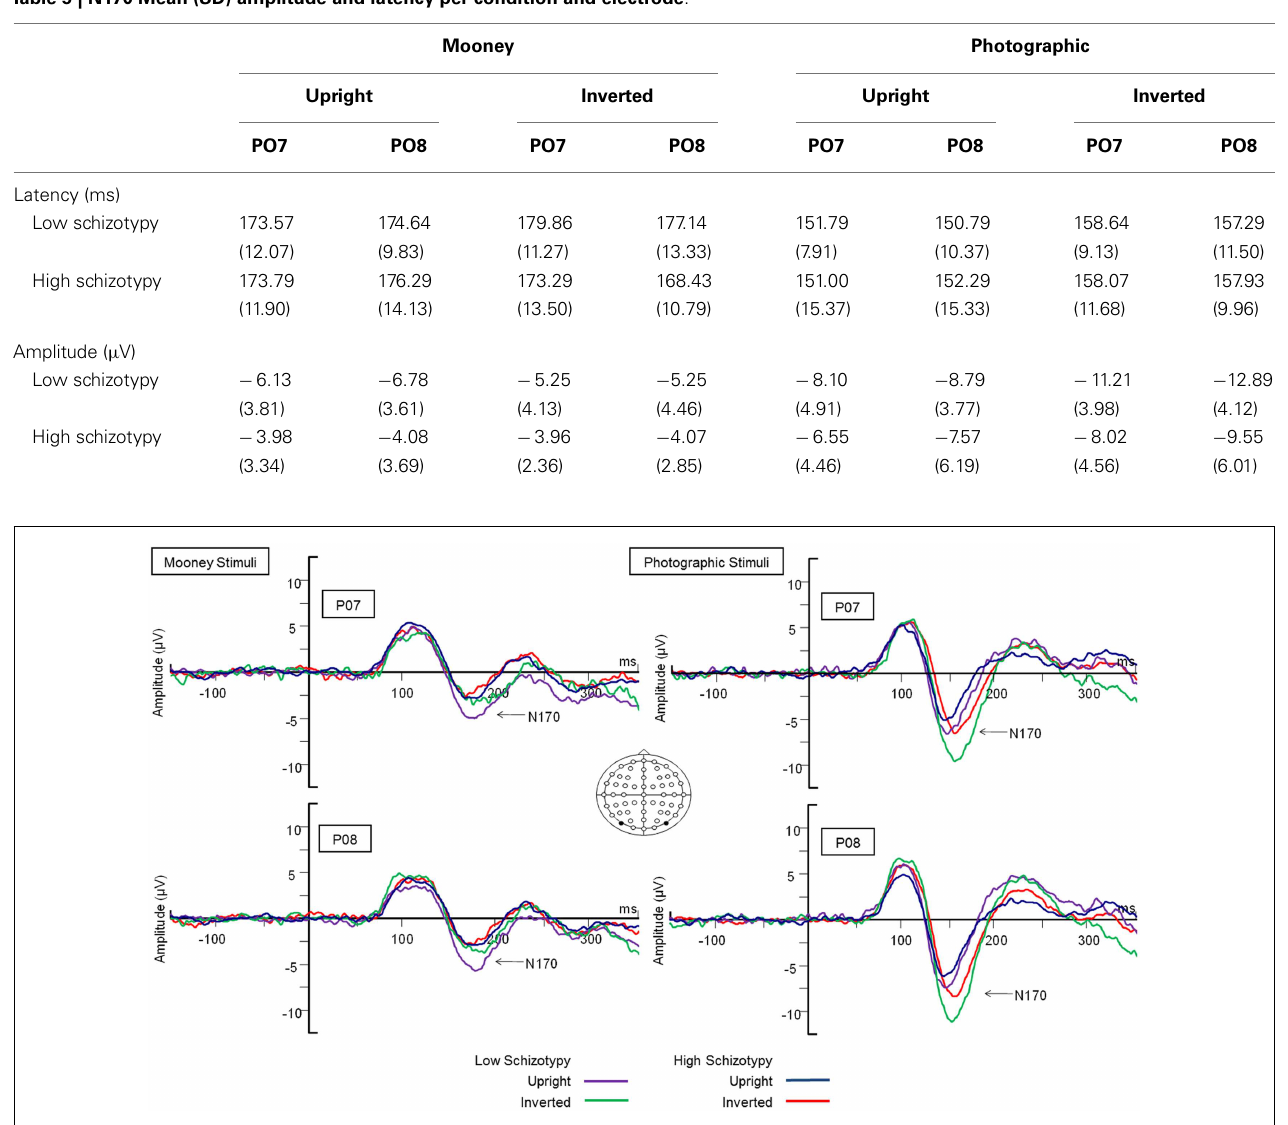
FIGURE 2 | Grand-averaged N170 waveforms at electrodes PO7 and PO8 . Upright and inverted stimuli presentations across groups are compared for both tasks. A bird’s eye view of the electrode montage is shown with the plotted electrodes shaded black. Negative polarity is plotted